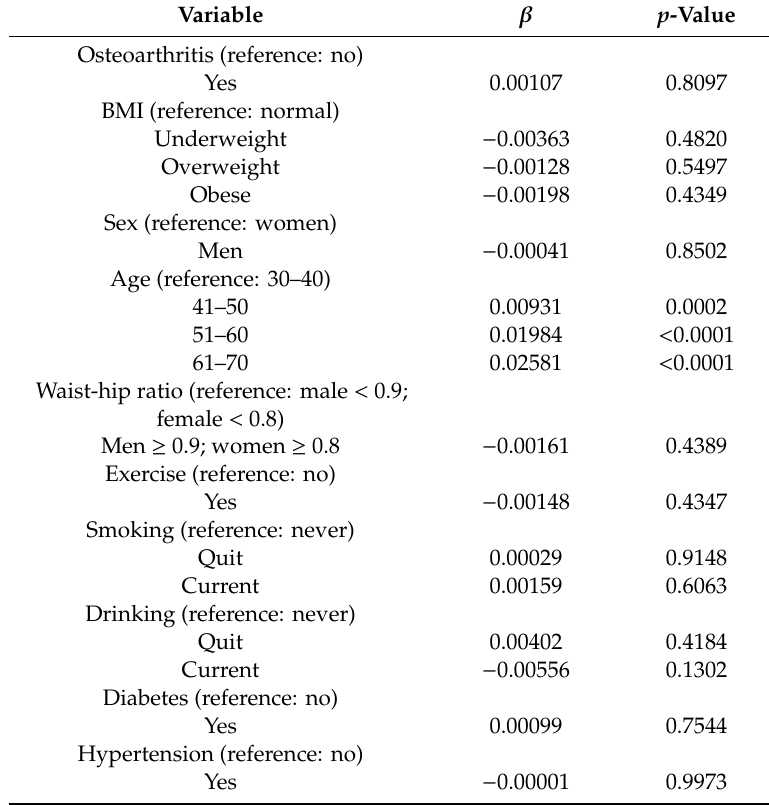
Table 2. Multiple linear regression showing the association of LEP promoter methylation with osteoarthritis and BMI.